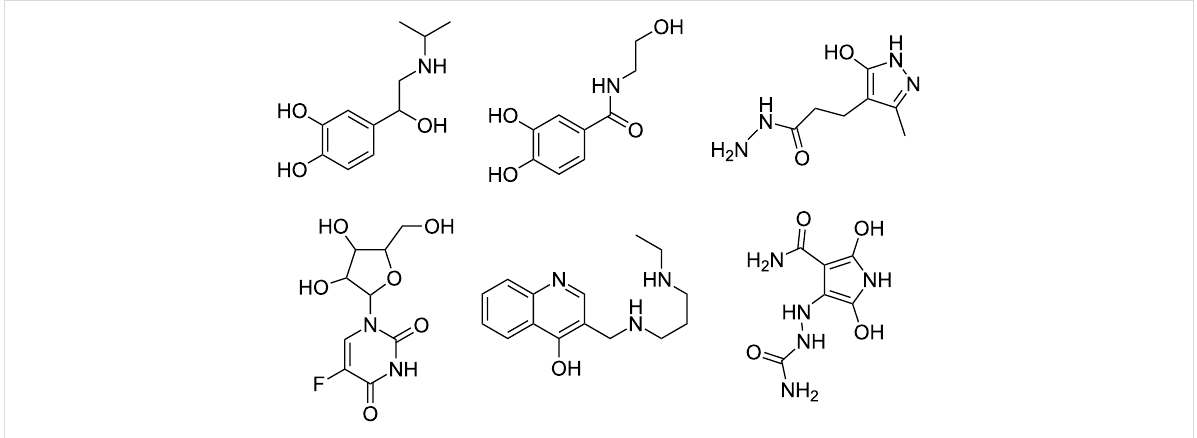
Figure 7: Compounds identified by Nowak and co-workers [37] in silico that selectively bind SOD1 over human plasma and inhibit A4V-SOD1 aggre- gation.